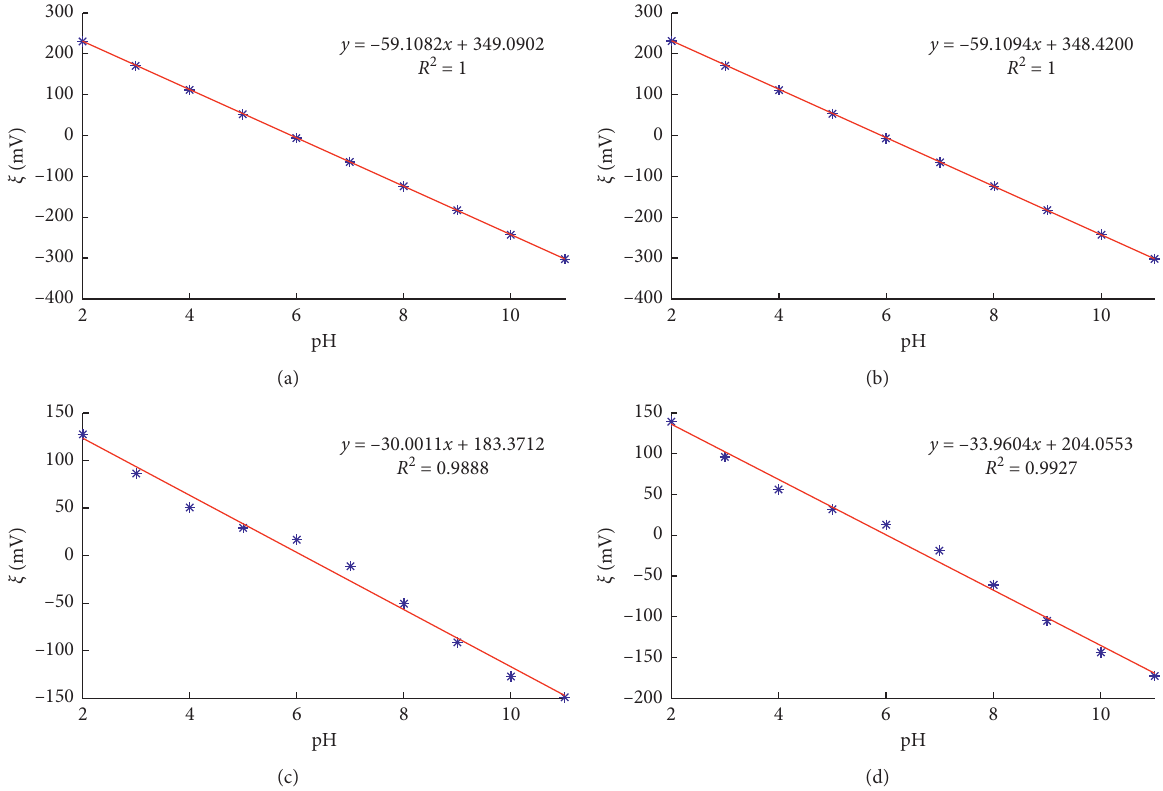
Figure 7: Total electrode potential ξ against pH for (a) RuO 2 (rutile: unhydrated), N s : 12.642, ε s : 55.23, (b) RuO 2 (rutile: hydrated), N s : 17.642, ε s : 55.23, (c) TiO 2 (rutile), N s : 2.7, ε s : 80, and (d) TiO 2 , N s : 5 (rutile), ε s : 80. The electrolyte is KCl for all